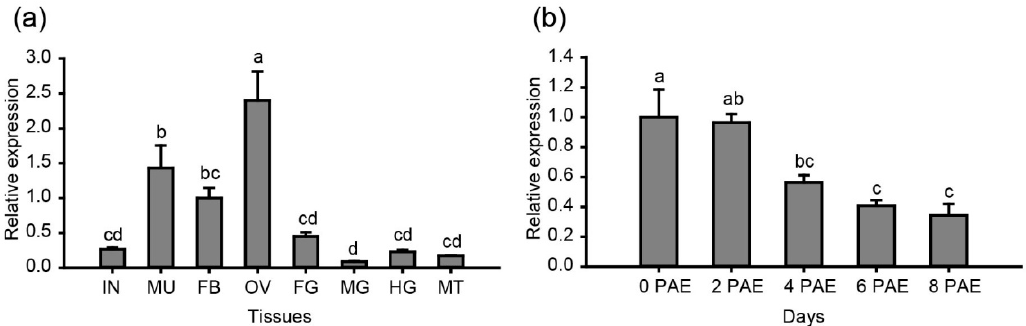
Figure 3. Expression profile of LmDDX6 in female adult locusts. ( a ) LmDDX6 mRNA expression in different tissues of female adult locusts at two days PAE. IN, integument; MU, muscle; FB, fat body, OV, ovary, FG, foregut, MG, midgut, HG, hindgut, MT, malpighian tubules. ( b ) Expression of LmDDX6 at different stages of adult ovary development. Data are presented as the mean ± standard error of the mean of three independent biological replicates. Data points indicated by different letters are significantly different.